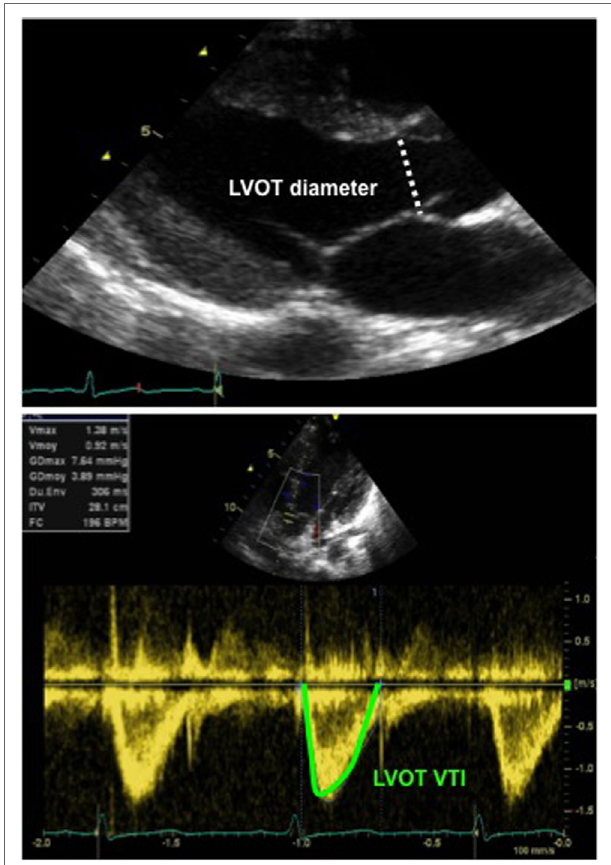
FigURe 10 | Echocardiographic assessment of cardiac output: 2D echocardiography long-axis view with measurement of LVOT diameter (above image), allowing for calculation of the LVOT CSA and Doppler tracing from an apical five-chamber view (below image) with tracing of the LVOT velocity to obtain the LVOT VTI. Abbreviations: CSA, cross-sectional area (calculated as π × r 2 and r , radius, diameter/2): LVOT, left ventricular outflow tract; VTI, velocity time integral (or mean